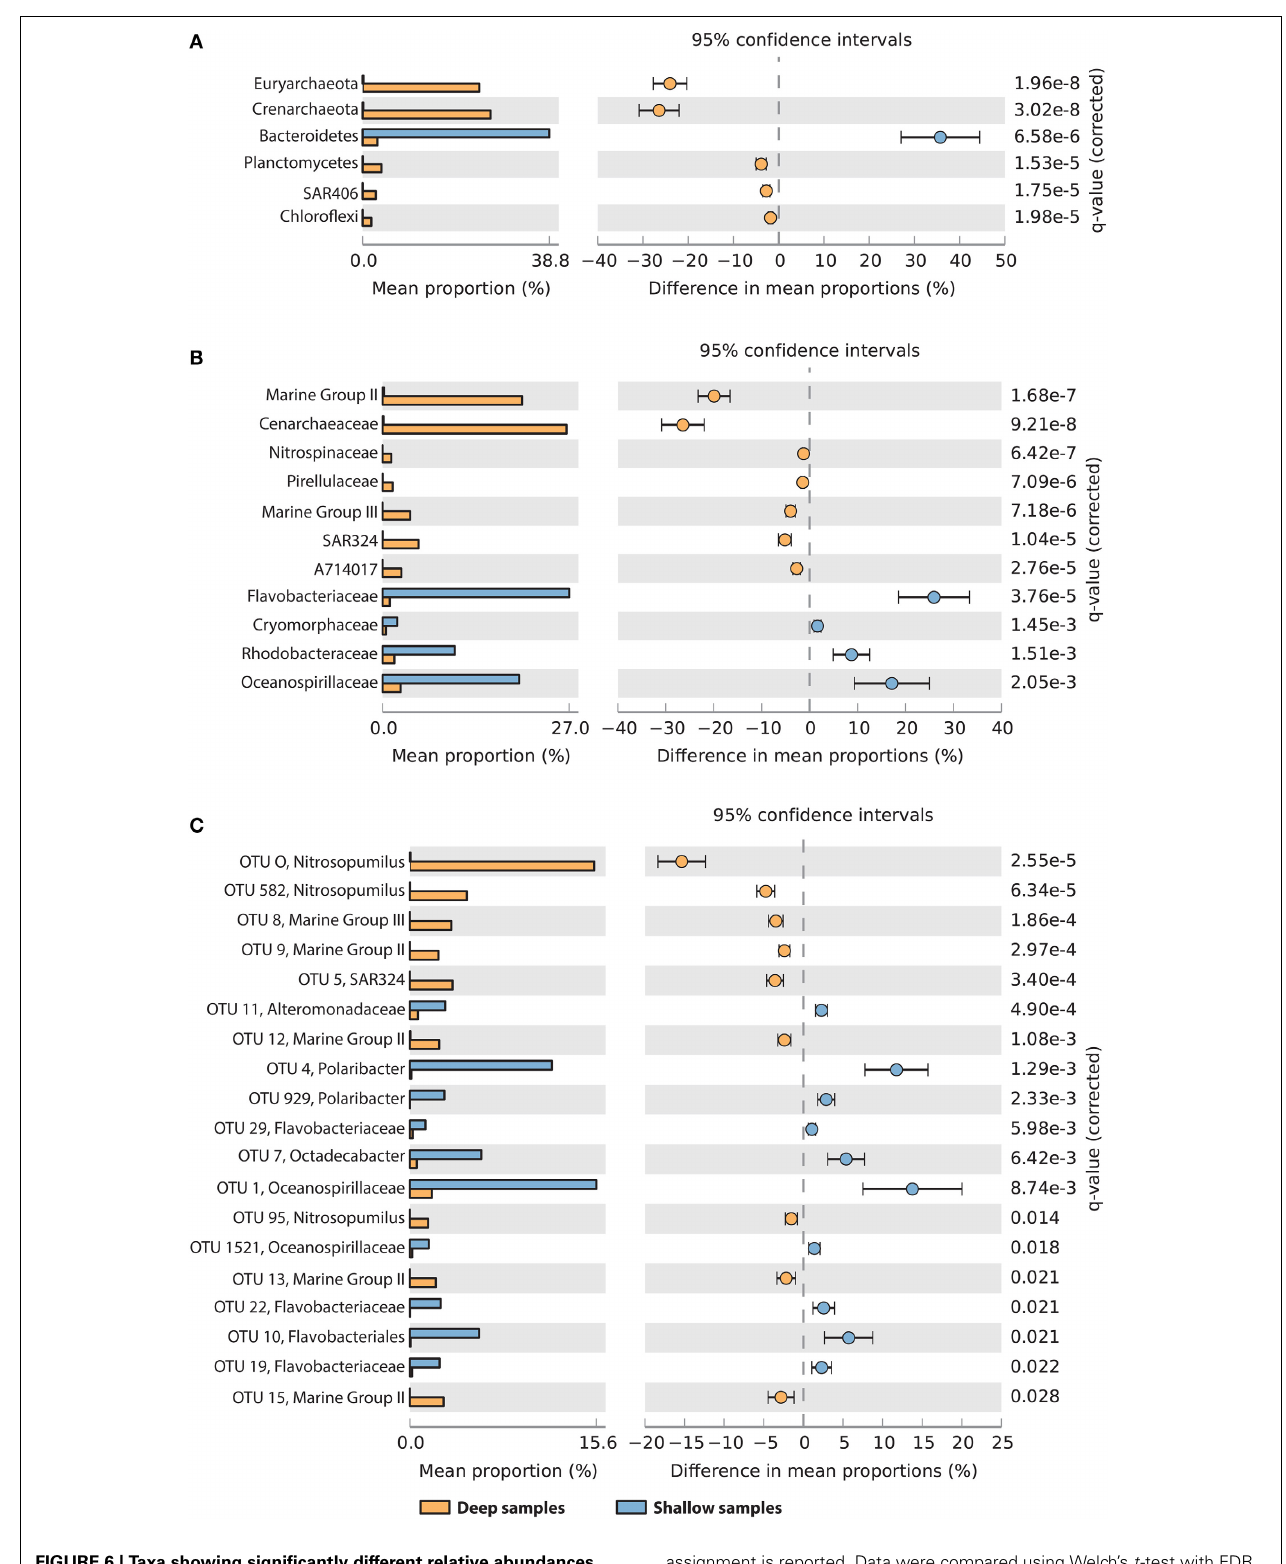
assignment is reported. Data were compared using Welch’s t -test with FDR correction of p -values. Differences were considered significant if q < 0 . 05 and filtered for effect sizes (difference between proportions > 1 or ratio between proportions >